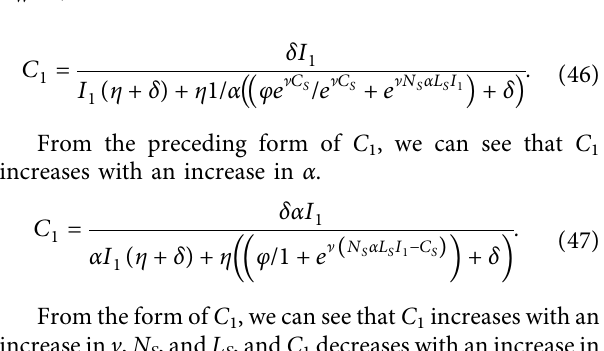
Figure 11: T 0 versus μ in the case where β C W � 1, and τ �